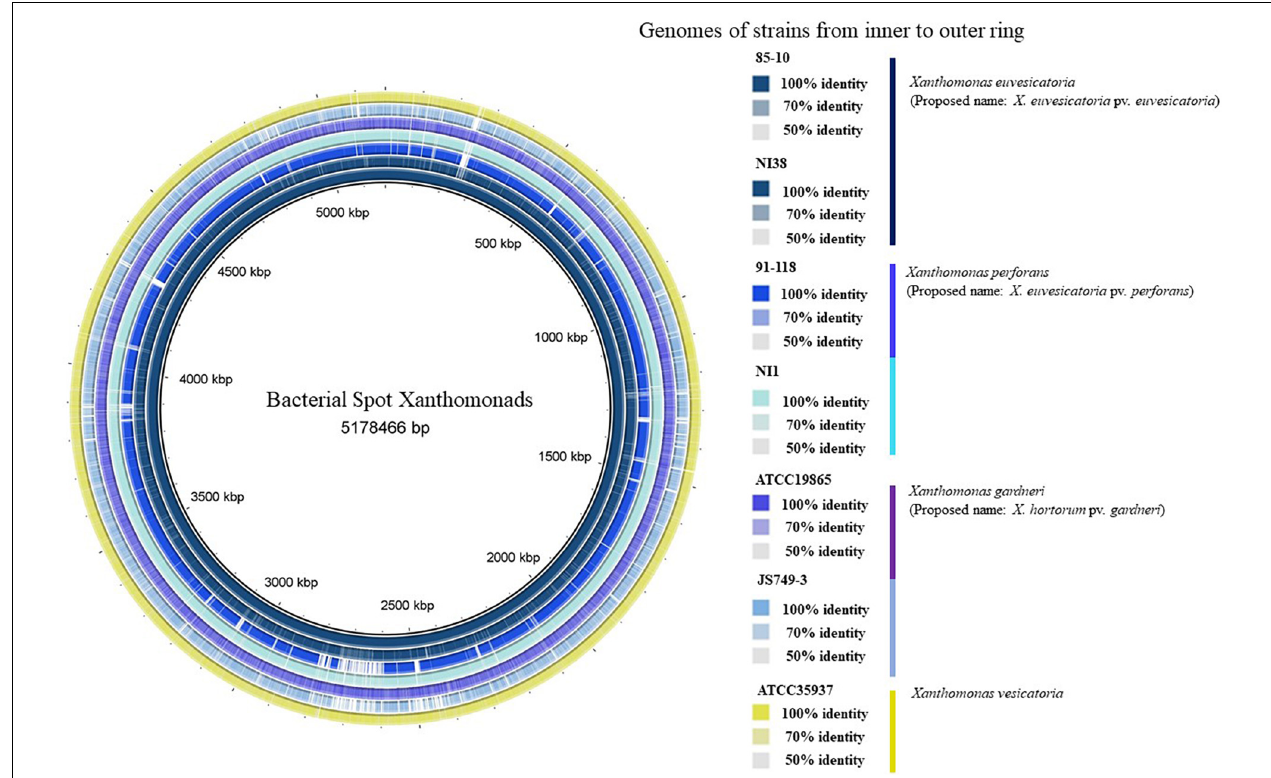
FIGURE 3 | Comparisons of reference strains of each bacterial spot species against sequenced representative strains from Africa. From innermost to outermost ring: Xanthomonas euvesicatoria 85-10, X. euvesicatoria NI38, X. perforans 91-118, X. perforans NI1, X. gardneri ATCC19865, X. gardneri JS749-3, and X. vesicatoria ATCC35937. There was no representative African X. vesicatoria strain, as no known strain has been sequenced. Varying color gradients in percentage identities are based on BLAST match of a minimum of 50% percentage identity (1e-5) of genomic regions against genome of strain 85-10 as shown in key. Because BLAST matches are calculated using 85-10 as reference sequences, regions that are absent from genome of strain 85-10 but present in one or more of other genomes are not displayed. Vertical lines in key are, respectively, colored according to color of each genome in ring. Circular genome was produced using BLAST Ring Image Generator (BRIG; Alikhan et al.,